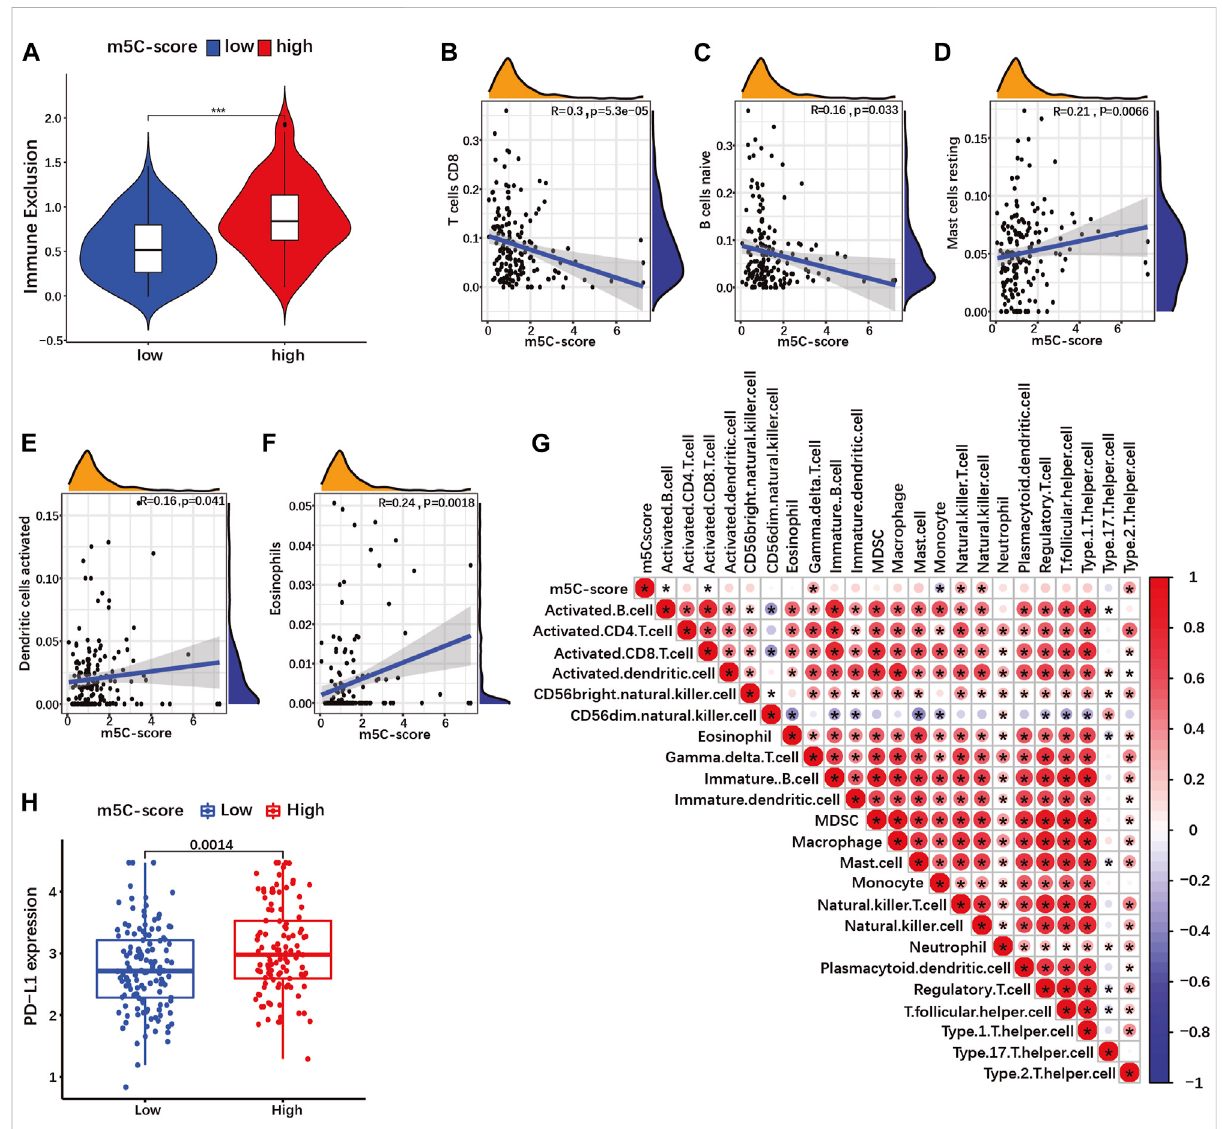
FIGURE 8 The m5C-score correlates with immune exclusion, low cytotoxic immune cells in fi ltration and PD-L1 expression. (A) Immune exclusion score between high- and low-m5C-score groups in the TCGA-PAAD cohort. (B – F) Spearman correlation of immune cells in fi ltration with m5C-score in TCGA-PAADandGSE57495cohortsanalyzedbyCIBORSORT. (G) Spearmancorrelationofimmunecellsin fi ltrationwithm5C-scoreinTCGA-PAAD and GSE57495 cohorts analyzed by ssGSEA. * p -value < 0.05. (H) Expression of PD-L1 between high- and low-m5C-score group in the TCGA- PAAD and GSE57495